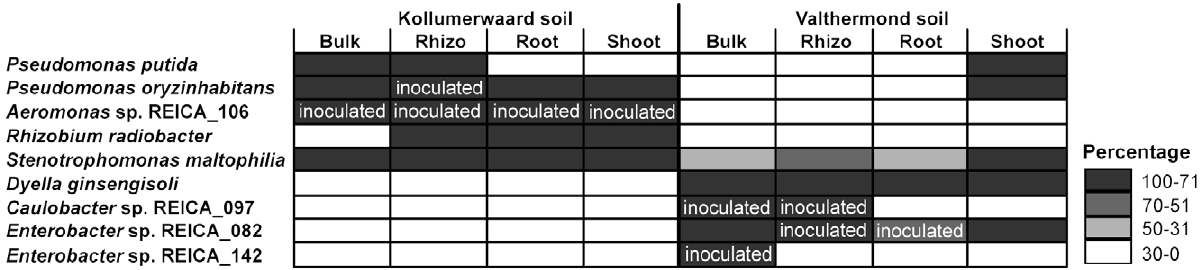
Figure 2. Heat map composition of selected bacterial communities. Distribution of select endophytic bacterial communities (rows) from two soil types (K and V) and four different habitats (root-free and rhizosphere soil, root and shoot endosphere) is shown. Cells are coloured in spectrum of grey that correlates with percentage of observed bacterium in a given habitat. Habitat from which the assessed bacterium was most likely to be originated from ‘artificial’ soil community is labelled with ‘‘inoculated’’. Unlabelled cells are most likely represented by assessed bacterium originated from rice seeds.